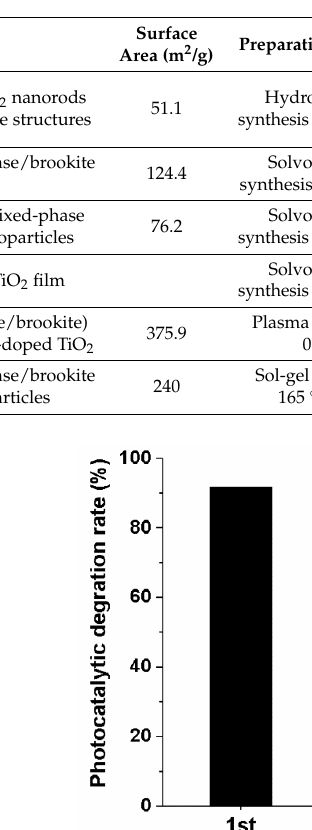
Table 2. Comparison of nitrogen-doped anatase/brookite biphasic TiO 2 prepared by various methods.